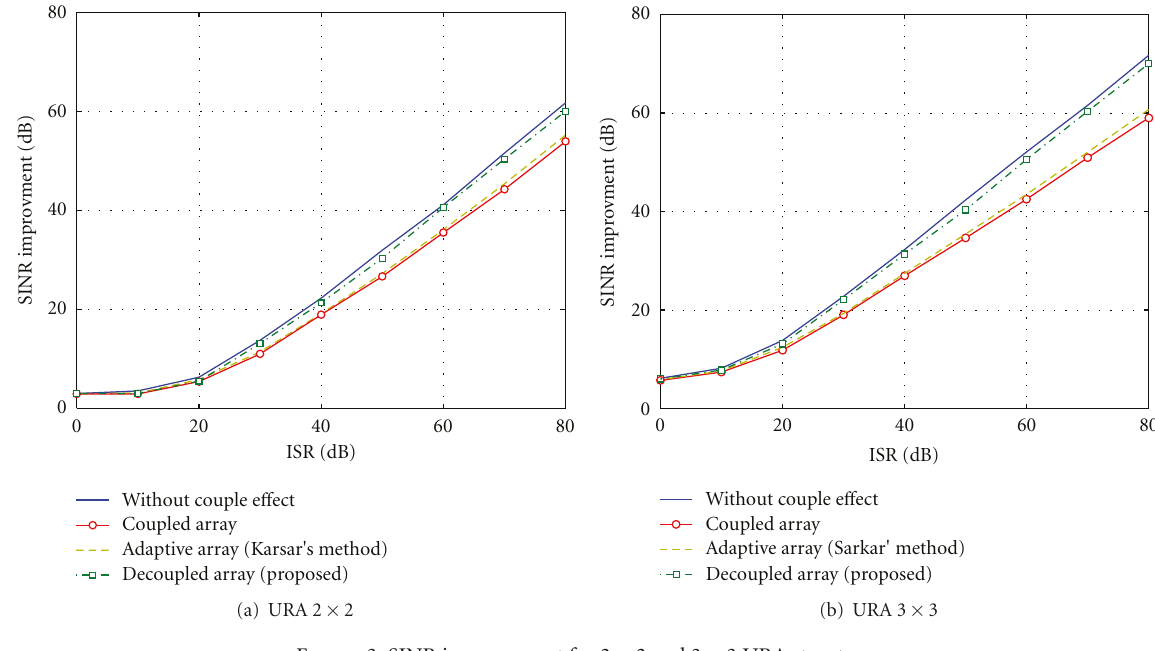
Figure 3: SINR improvement for 2 × 2 and 3 × 3 URA structure.